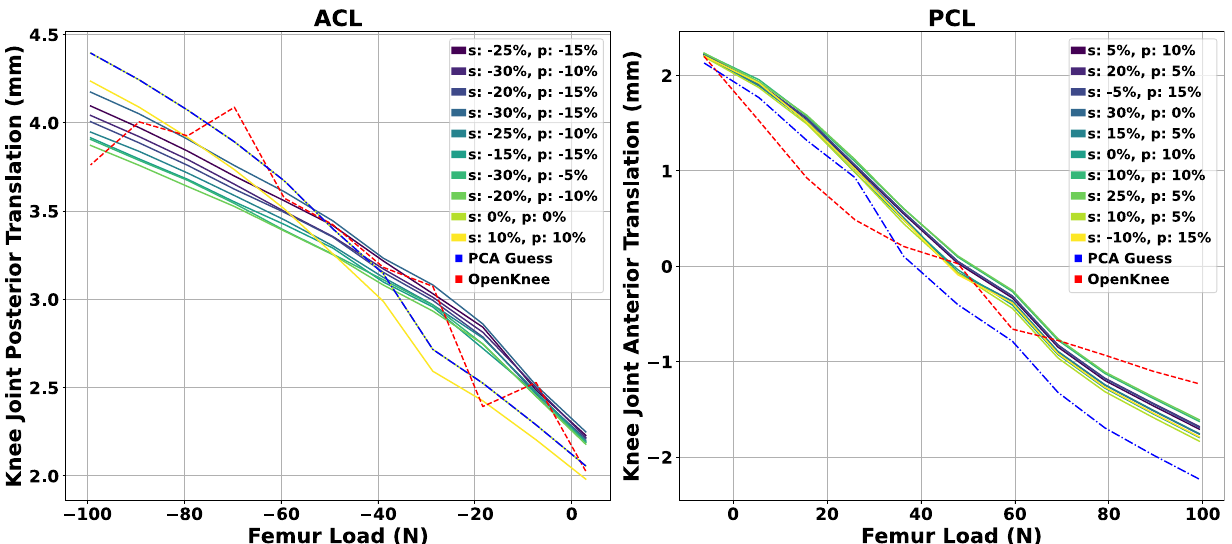
Figure 5. Aggregated results from the sensitivity analysis with the ten best combinations of stiffness and prestrain values for ACL and PCL. The estimated stiffness (PCA method) and recommended prestrain value from Blakenvoort were used as initial guesses. The “s” and “p” denote the stiffness and prestrain percentage change, respectively. In addition, we observed combinations that include the initial stiffness value and changed only the prestrain by a